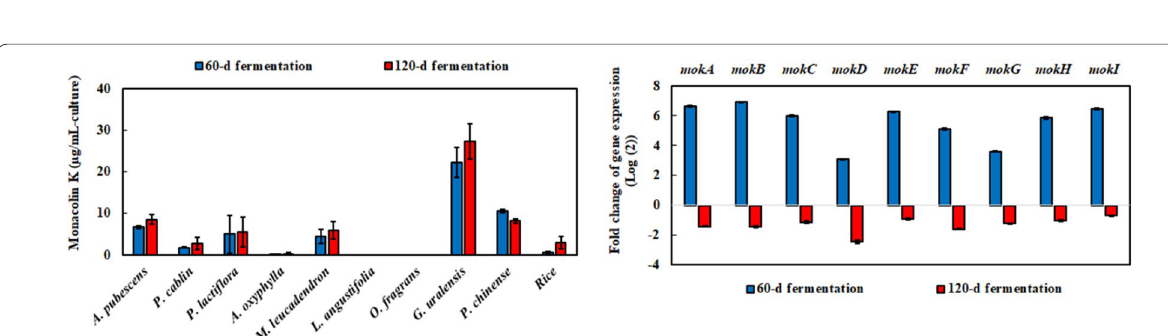
Fig. 5 Red pigment with the fermentation of medicinal plants by M. ruber BCRC 31,535 and detected by the absorbance of OD 505 . Results are mean S.D. (n 3) ± =